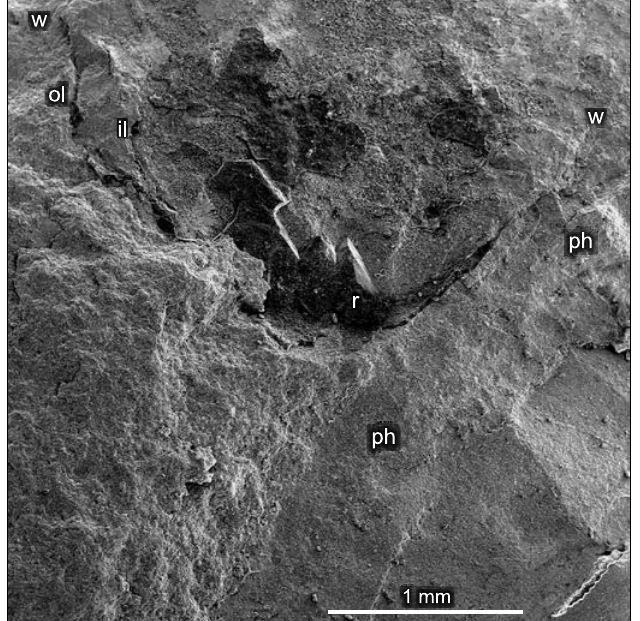
Fig. 13. Coleoid cephalopod Lunzoteuthis schindelbergensis Doguzhaeva, Summesberger, and Mutvei, 2006 (holotype, NHMW 2005z0005/0001); lower Carnian, Upper Triassic; Schindelberg, Lower Austria. SEM image of a fractured lower beak in a contact with the phragmocone. Abbreviations: il, inner lamella of the lower beak; ol, outer lamella of the lower beak; ph, phragmocone; r, rostrum of the lower (ventral) beak; w, wing of the